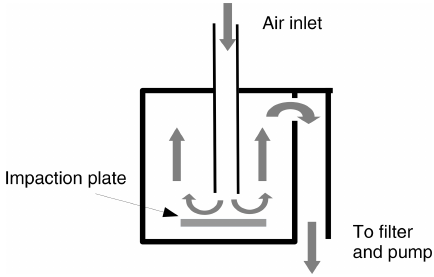
Figure 2. Internal structure of PM10 sampling